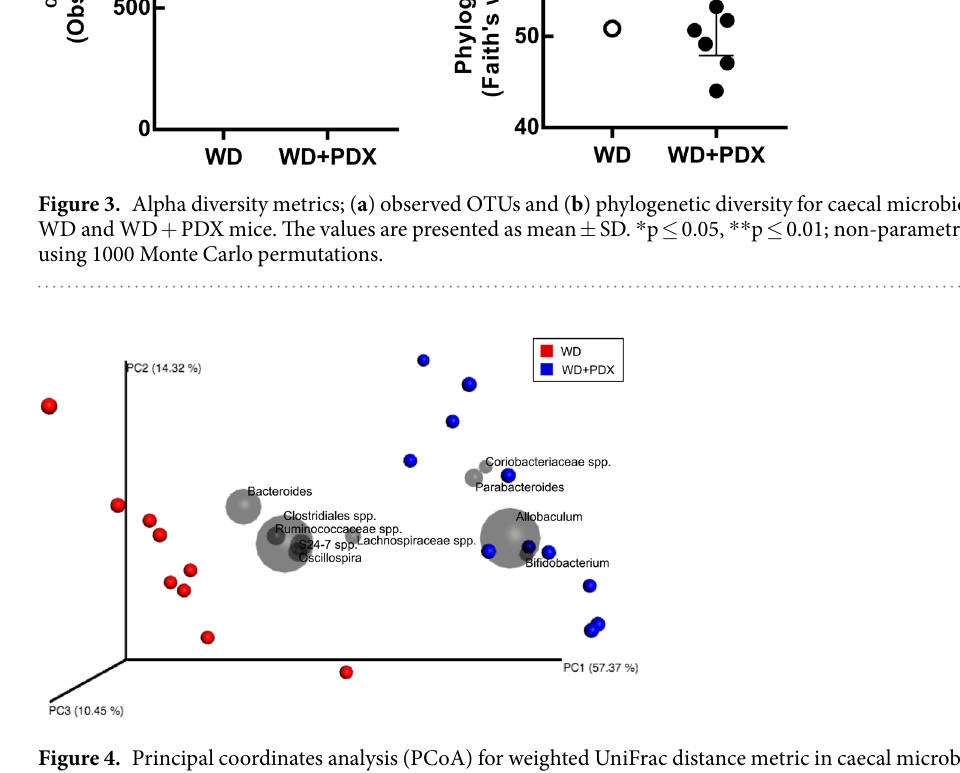
Figure 4. Principal coordinates analysis (PCoA) for weighted UniFrac distance metric in caecal microbial communities from WD and WD + PDX mice. The top 10 most abundant taxa are plotted using grey circles. The circle size is proportional to abundance of each genus, thereby illustrating taxa that are driving differentiation between the microbial communities. Sample clustering by diet is significant p < 0.001